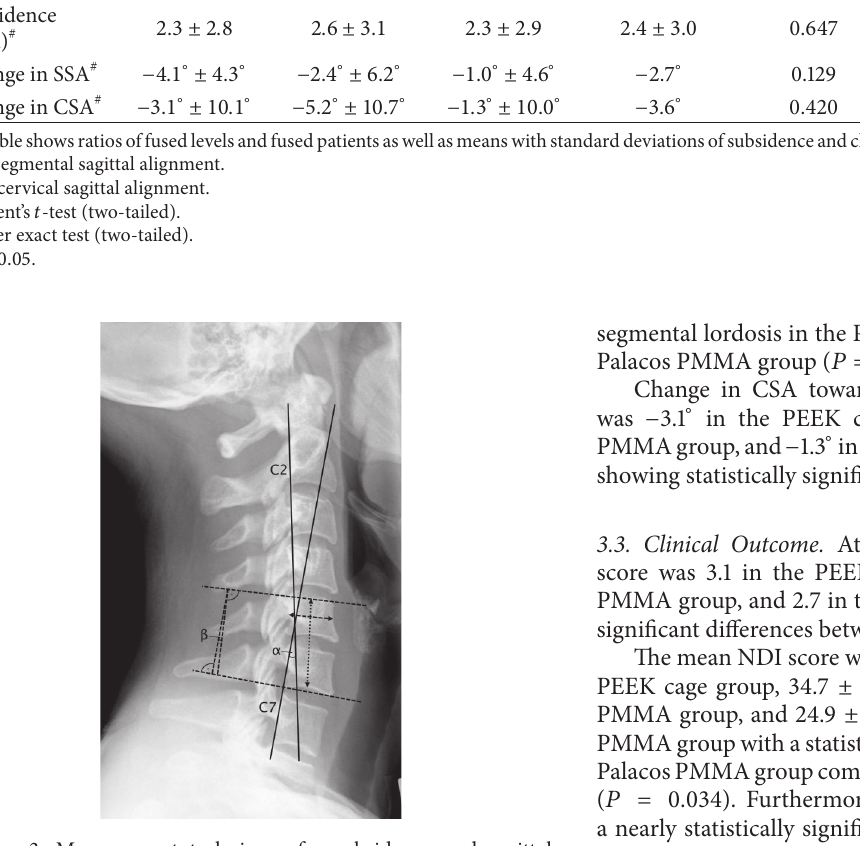
Figure 3: Measurement techniques for subsidence and sagittal alignments. The interbody height ratio of C5/6 is the total seg- mental height (vertical dotted line with arrowheads) divided by the anterior-posterior diameter of C5 (horizontal dashed line with arrowheads). 𝛼 is the angle indicating the cervical sagittal alignment (CSA); 𝛽 is the angle indicating the segmental sagittal alignment